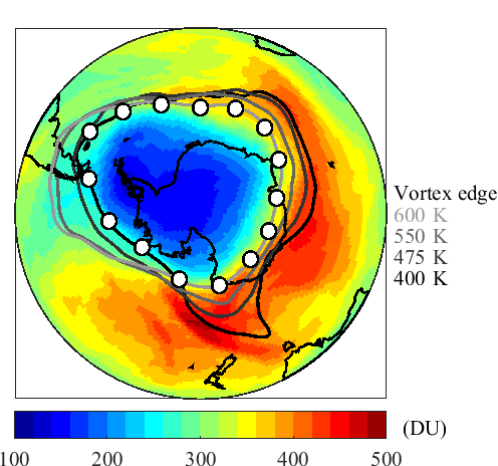
Figure 1. Total ozone (DU) from MSR-2 on 7 October 2012 at 12:00UTC. Vortex edge position at different isentropic levels are added to the map and represented by black to light grey lines. White dot marks identify the region considered inside the vortex using the 400–600K range